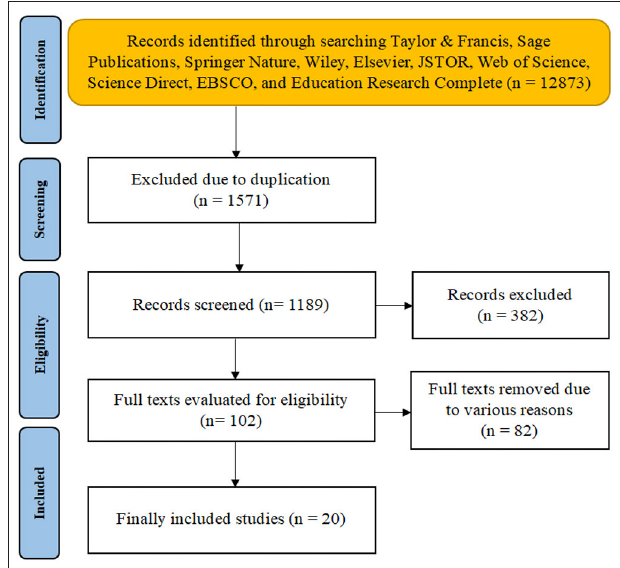
FIGURE 1 | A flow chart of literature